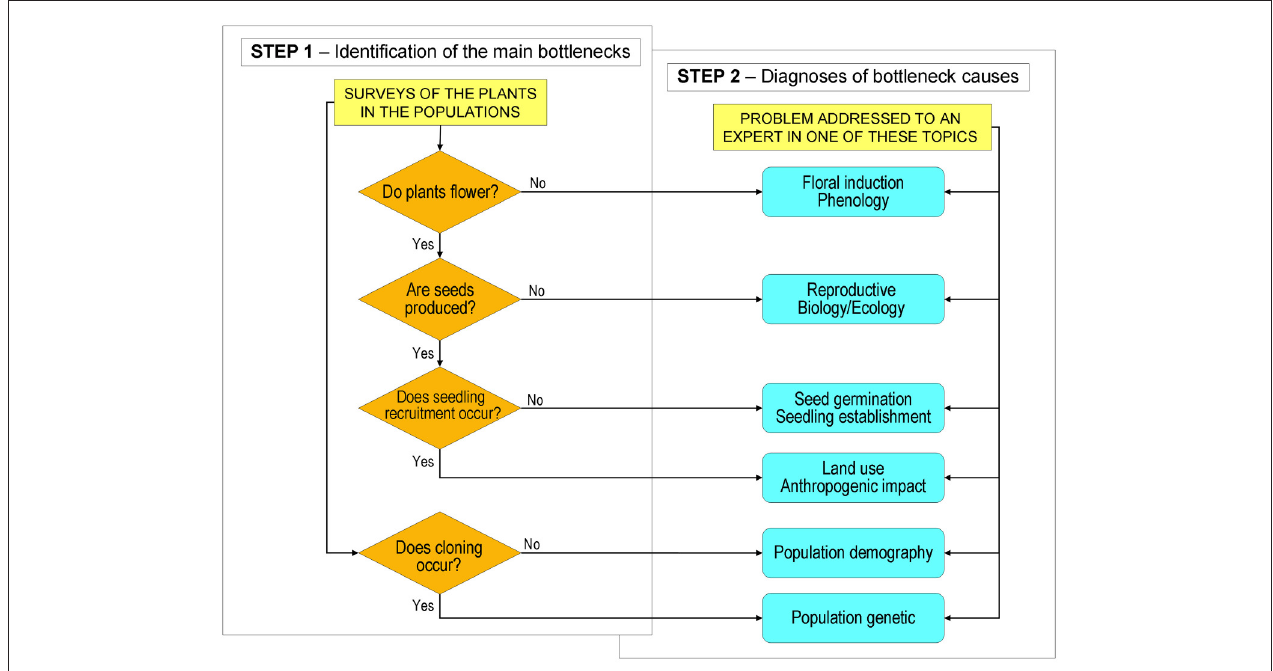
FIGURE 2 | Illustrative path diagram of Step 1 and Step 2 of the SHARP procedure. Step 1 is aimed to check with field surveys the successful achievement of the main stages of the life cycle. Failure to reach one of the stages suggests the occurrence of a bottleneck. In Step 2, according to the bottlenecks identified in Step 1, a researcher with specific expertise is involved to clarify the causes of the bottlenecks and suggest applicable countermeasures. Reported bottlenecks have to be considered as an illustrative, yet incomplete list of cases.